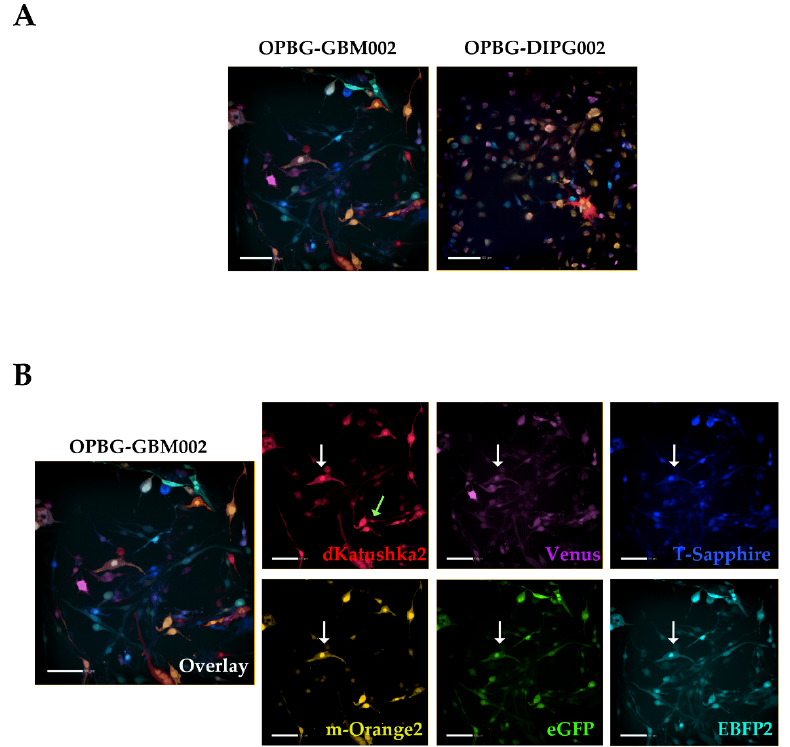
Figure 4. pGBM and DIPG multifluorescent primary cell lines analyzed at the Operetta CLS. ( A ) Representative images of the OPBG-GBM002 and OPBG-DIPG002 multifluorescent bulk cell lines, acquired on Operetta CLS. ( B ) The representative merged fluorescent image for OPBG-GBM002 is splitted into six panels, one for each protein: dKatushka2 (red), m-Orange2 (yellow), Venus (magenta), eGFP (green), T-Sapphire (blue), and EBFP2 (cyan). Light green and white arrows indicate respectively one-fluorescence and multifluorescent cells. All images were acquired using Operetta CLS